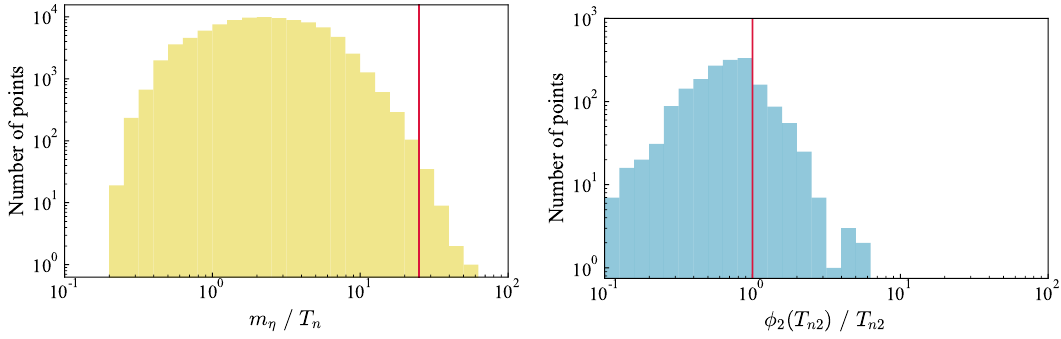
Figure 2 . Distribution of the number of parameter sets as a function of m η /T n for the one-step PTs (left) and φ 2 ( T n 2 ) /T n 2 for the two-step (right) PTs, respectively. The red vertical lines show the thresholds m η /T n = 25 and φ 2 ( T n 2 ) /T n 2 = 1 .